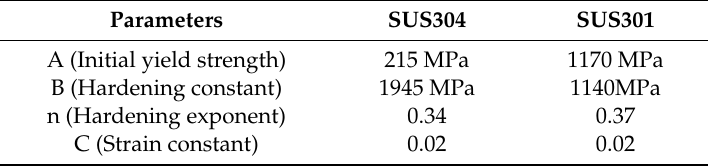
Figure 3. Stress–strain curve of SUS301 based on strain rate variations. Table 1. Constants of Johnson–Cook model for the haptic spring.